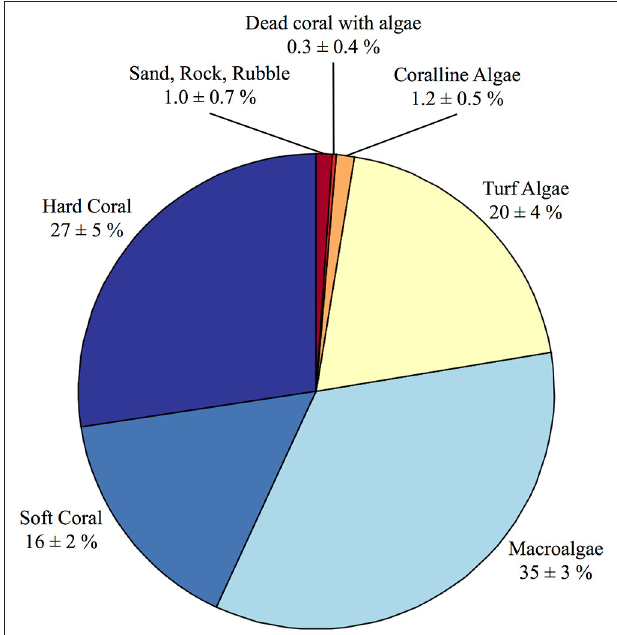
FIGURE 2 | Summary of percent cover ( ± standard deviation) from the benthic surveys conducted at Hog Reef. The benthic survey percent cover data was used in conjunction with the effective footprint analysis to scale the benthic composition onto larger spatial patterns of rocky reef-dominated (94.9 ± 0.2%) and sand-dominated (5.1 ± 0.2%) substrates at Hog